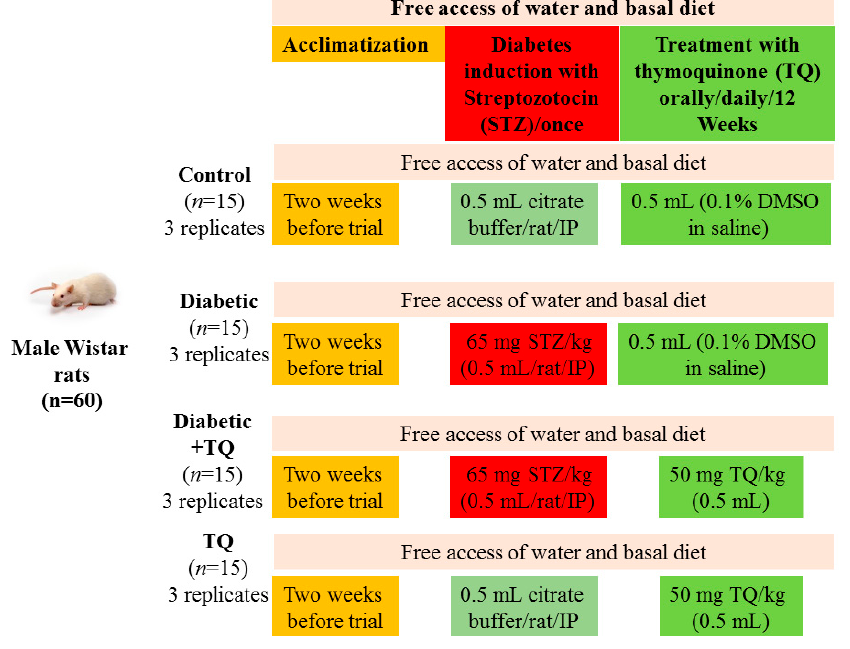
Figure 1. Experimental design.